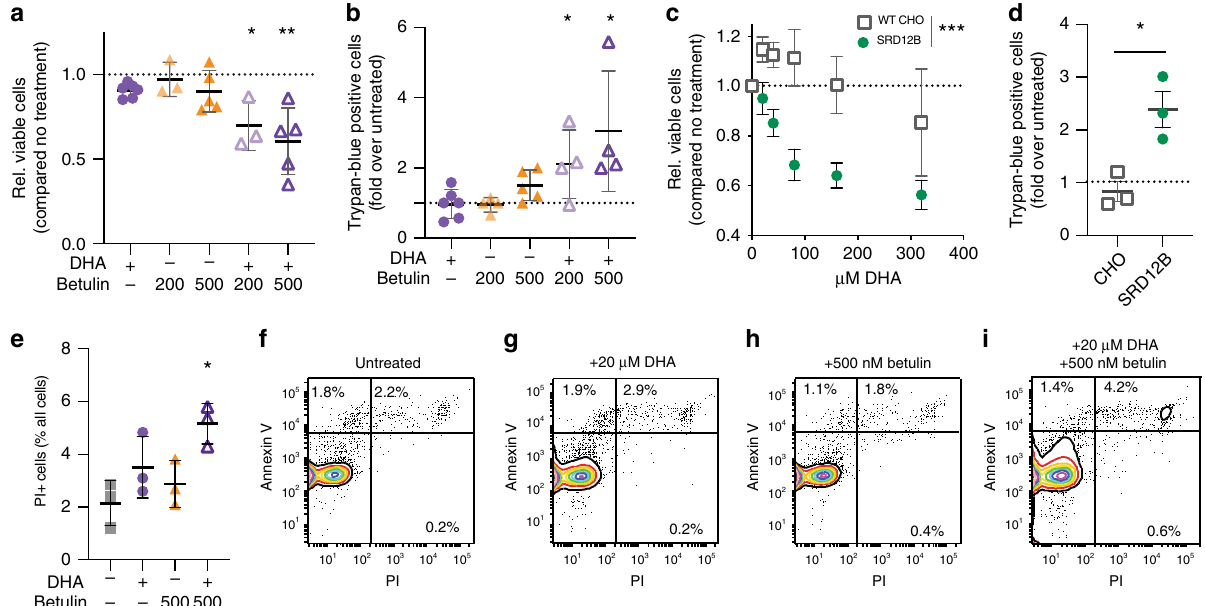
Fig 6 Inhibition of homeostatic lipidome remodeling induces non-apoptotic cytotoxicity. a Neither DHA nor betulin alone were cytotoxic in RBLs, whereas their combination signi fi cantly reduced viability. Full dose-response in Supplementary Fig. 10a b 24 h of DHA + betulin treatment signi fi cantly increased trypan-positive cells. c In SRD-12B cells, which fail to upregulate cholesterol and saturated lipids upon DHA treatment (see Fig. 4d and Supp Fig. S6), DHA signi fi cantly inhibited cell growth, in contrast to control WT CHO cells. d In SRD-12B cells, DHA signi fi cantly increased the proportion of TB